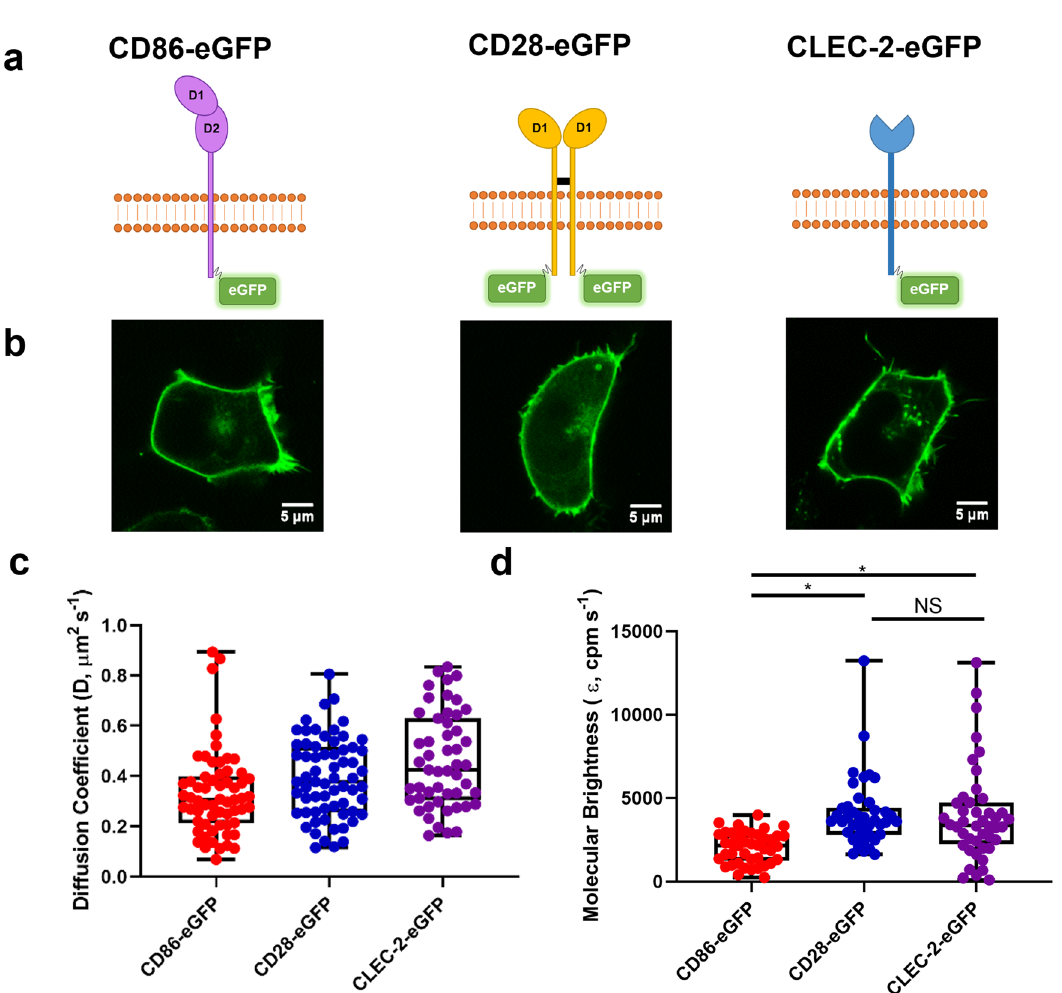
Fig. 7 Fluorescence correlation spectroscopy (FCS) shows CLEC-2 is a mixture of monomers and dimers. a Schematic representation of C-terminal CD86-eGFP monomer control, CD28-eGFP dimer control and N-terminal human CLEC-2-eGFP. eGFP tags have an A206K mutation to prevent eGFP dimerisation. D1 = domain 1 and D2 = domain 2. b Representative confocal microscopy images showing membrane localisation of CD86-eGFP, CD28- eGFP and CLEC-2-eGFP in transfected HEK293T cells ( fi eld of view = 52 × 52 μ m) (scale bar = 5 μ m). c Box plot of CD86, CD28, and CLEC-2 diffusion coef fi cient data in HEK293T cells. The diffusion coef fi cients were calculated from the derived autocorrelation fi ts. d Photon counting histogram (PCH) analysis of CD86, CD28 and CLEC-2 to determine molecular brightness ( ε , counts per molecule per second, cpm s − 1 ) and stoichiometry of the receptors in HEK293T cells. 1-component PCH fi tting was applied to raw PCH. NS = not signi fi cant. For all box plots, centre lines represent the median; box limits indicate the 25th and 75th percentiles and whiskers extend to minimum and maximum points. Signi fi cance was measured with Kruskal-Wallis with Dunn ’ s post-hoc where P ≤ 0.05. FCS measurements were taken in 53 – 70 cells ( n = 6 biologically independent experiments).